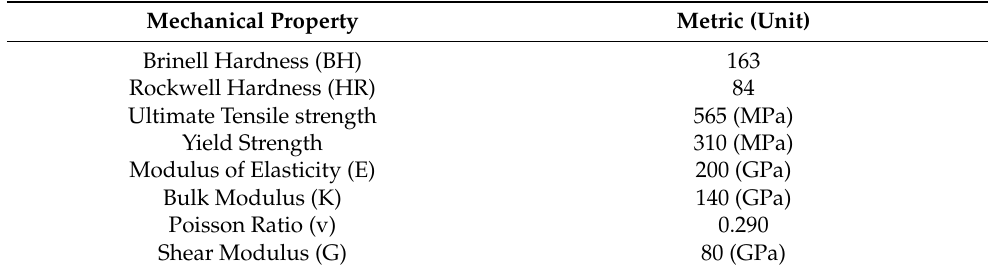
Table 2. Mechanical properties for AISI 1045 medium carbon steel [44].